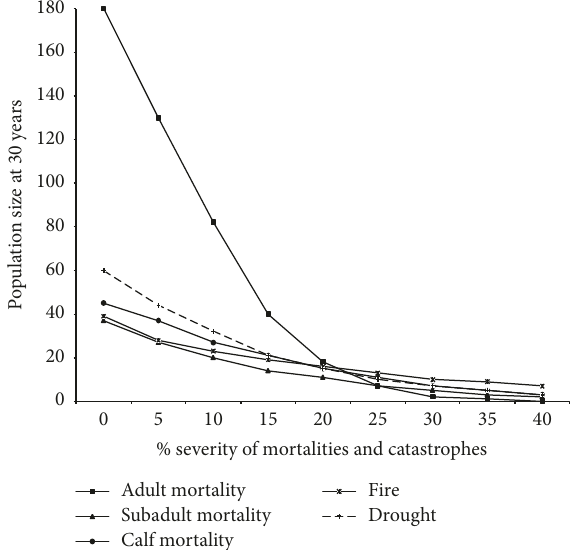
Figure 3: The impact of age-specific mortalities and catastrophes on roan population viability. The mean population size at 30 years was obtained by simulating a PVA model over a 30-year period with an initial population of 43 roans under varying levels of age-specific moralities and catastrophes from 0% to